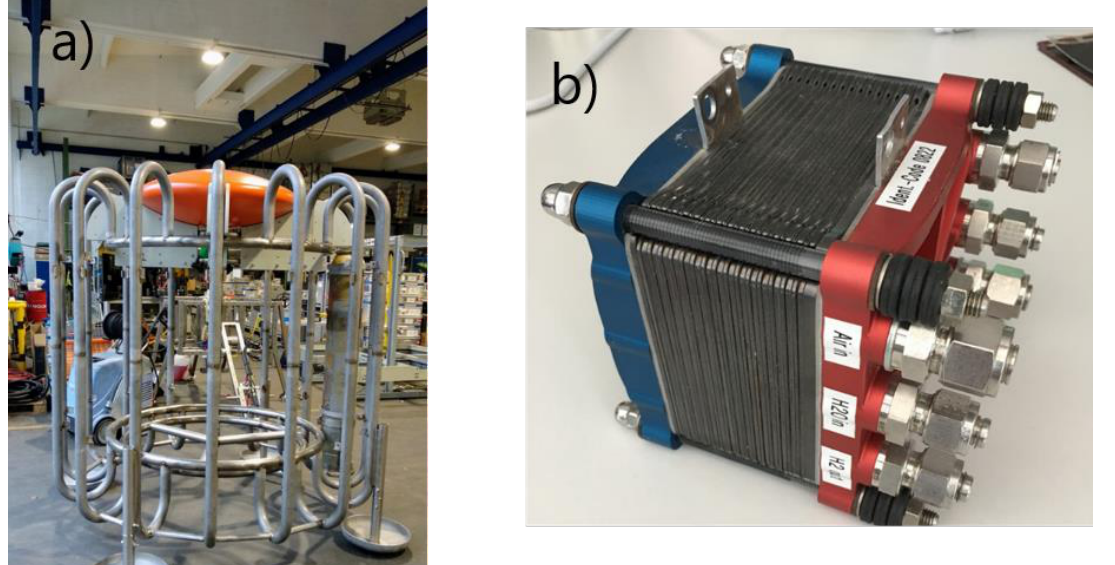
Figure 4. Long-term operation with a fuel cell and power storage system provides the basis for advanced marine research infrastructures. The frame on the left ( a ) shows the lander system that will carry the fuel cell components in the center with the gas bottles occupying the surrounding slots. On the right ( b ) is the membrane system of the fuel cell.